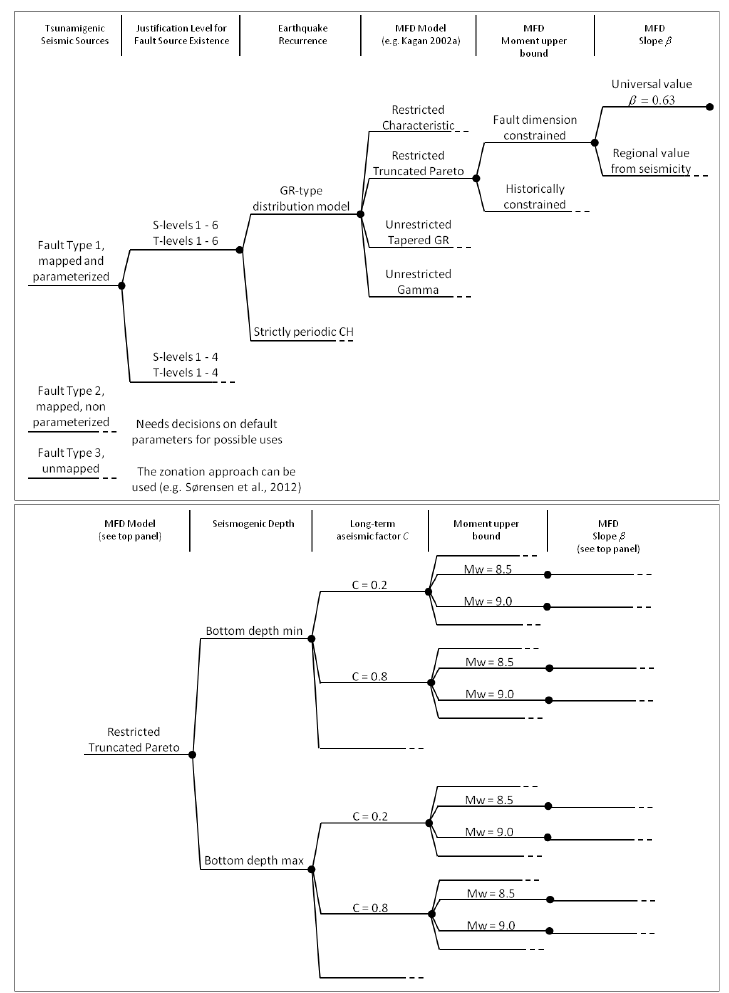
Fig. 2. Example of a simplified logic tree for fault source parameters (Fault Type 1); weights are not assigned. The upper panel is dedicated to crustal fault sources. The lower panel shows a nested branch emanating from the MFD model node for treating additional epistemic uncertainties in the recurrence rate estimation for subduction sources. Notice that some of these quantities may also, or even preferably, be treated as distributions rather than branches (e.g. moment upper bound). Different model strategies may also apply to fault sources (Fault Type 1) with lower justification level and/or for fault sources characterized by different sets of parameters (Fault Types 2 and